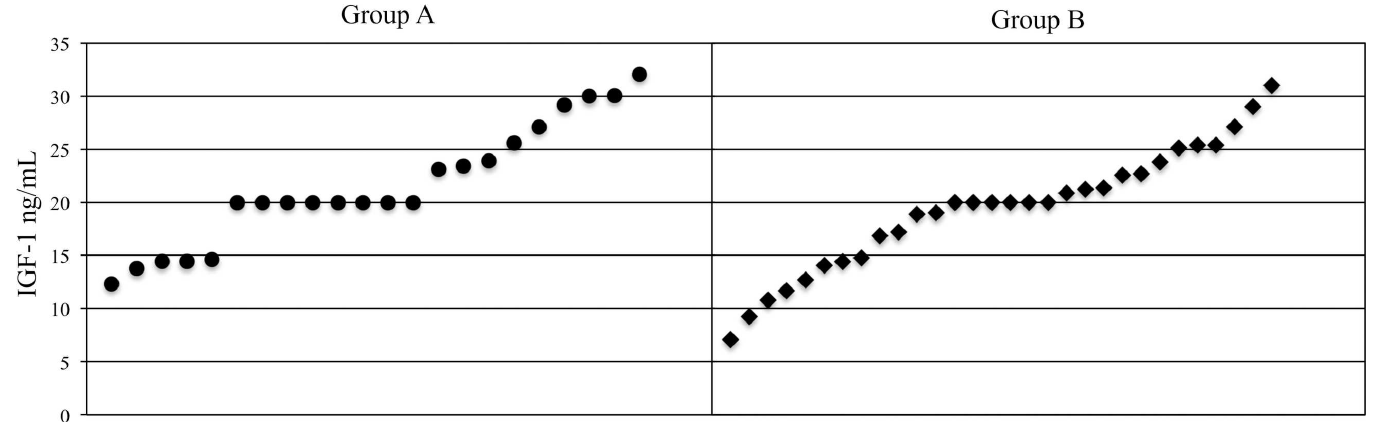
Fig 2. IGF-1 plasma level distribution at 32 weeks of PMA. The figure shows the individualvalues of IGF-1 in all newbornsof group A and group B at 32 weeks of PMA: IGF-1 distributionand range values are similar in the two study groups(p 0.48).